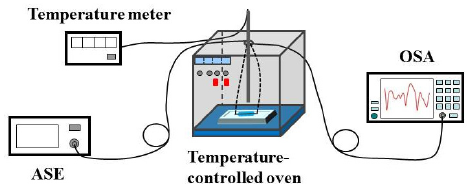
Figure 2. Experimental setup.